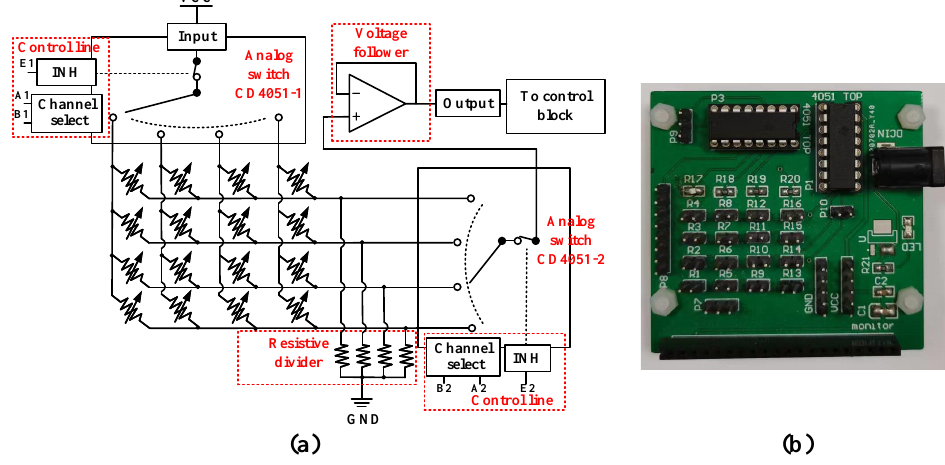
Figure 8. ( a ) A schematic of the tactile acquisition circuit; ( b ) a photograph of the acquisition